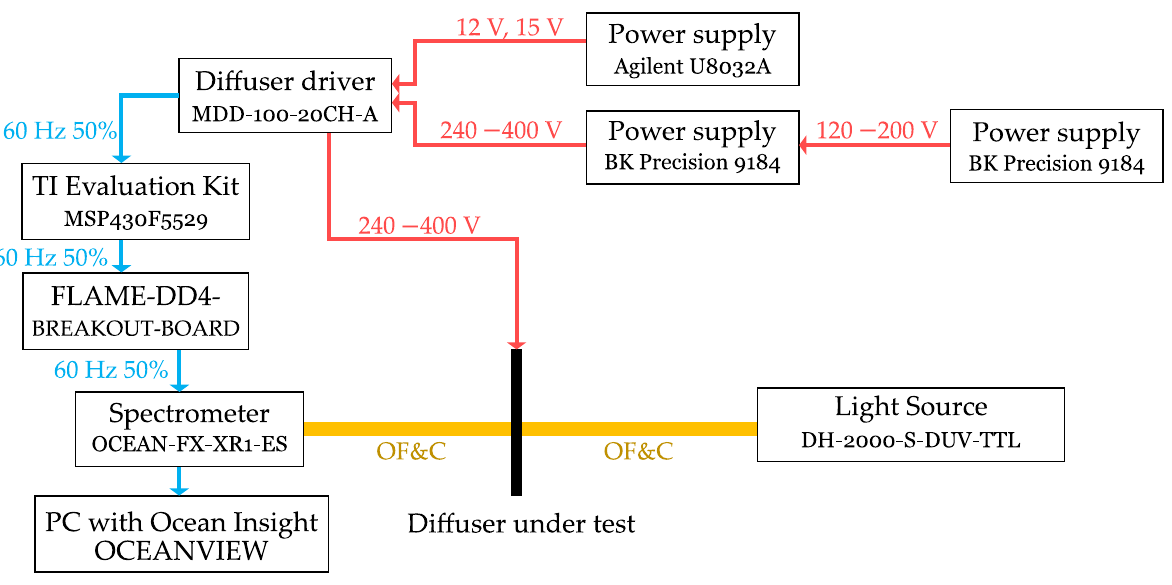
Figure 2. Setup for spectra dynamics characterization.